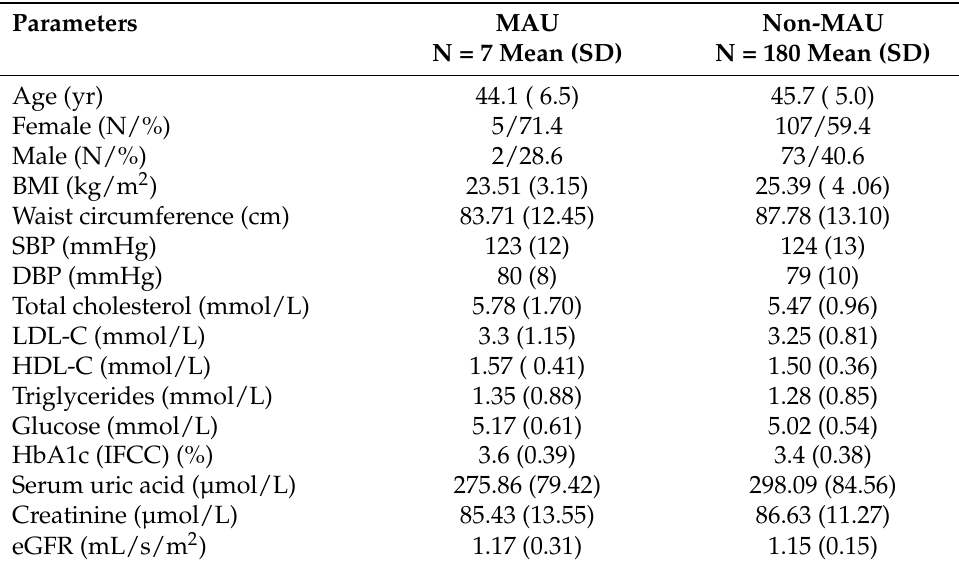
Table 1. Comparison of mean values and standard deviations (SD) of continuous demographic, clinical, and laboratory parameters between groups with and without microalbuminuria assessed with t -test. Number of males and females between groups with and without microalbuminuria compared using Person’s chi squared test. No statistically significant differences were found.